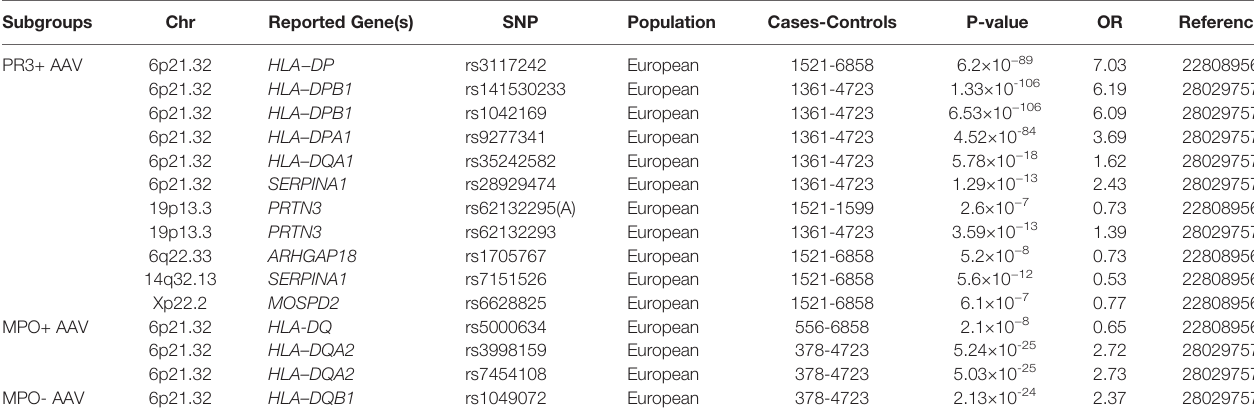
TABLE 2 | Summary of main genetic associations with antineutrophil cytoplasmic antibody (ANCA)-associated vasculitis through genome-wide association studies, according to ANCA subgroups. Subgroups Chr